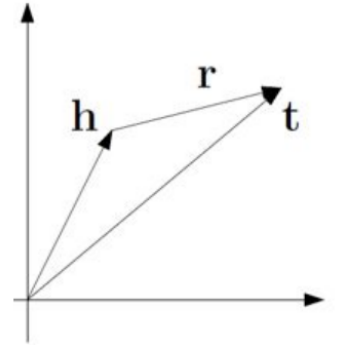
Figure 7. TransE algorithm description